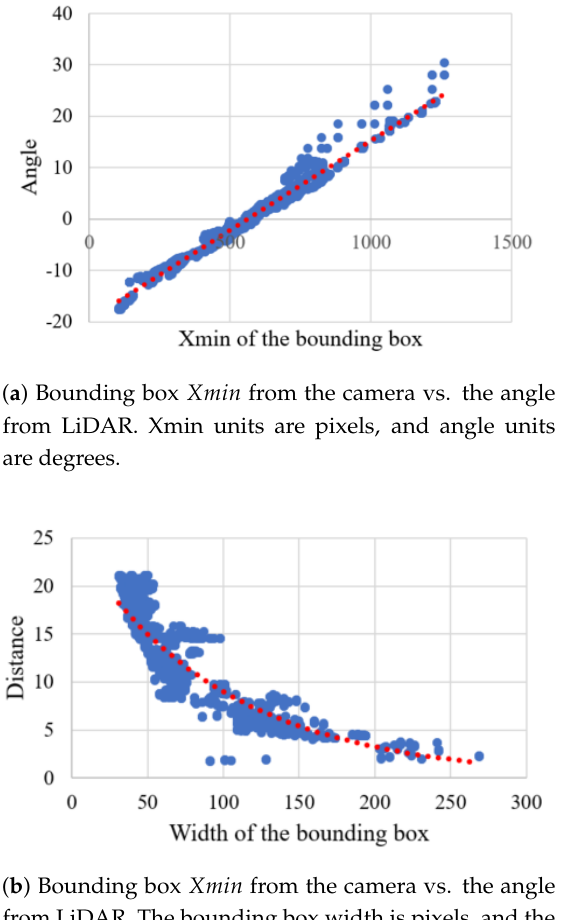
Figure 24. Scatter plots of camera/LiDAR training data for fusion. ( a ) Camera bounding box Xmin vs. LiDAR estimated angle. ( b ) Camera bounding box width vs. LiDAR estimated